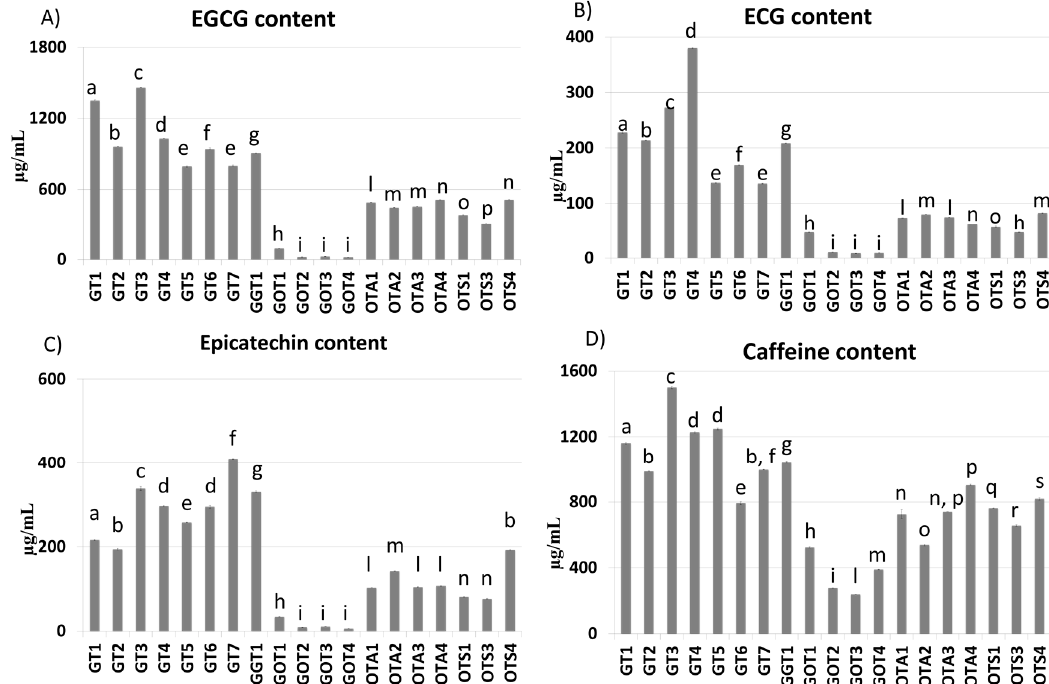
Figure 4. EGCG ( A ), ECG ( B ), EC ( C ), and caffeine ( D ) concentrations ( µ g/mL of tea beverage) in the 19 analyzed teas. Data are expressed as mean of three independent measurements ± SD; different letters indicate statistically significant differences ( p < 0.05) between two groups.